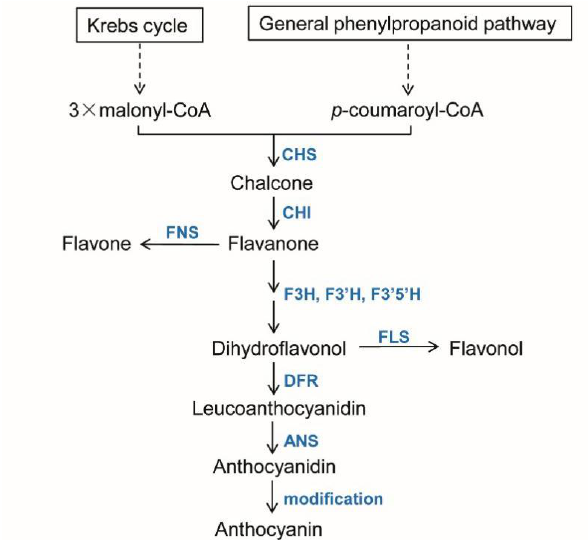
Figure 1. A schematic view of the biosynthetic pathways of flavonoids. The biosynthesis of flavonoids begins with the condensation of one molecule of p-coumaroyl-CoA derived from the general phenylpropanoid pathway (GPP) and three molecules of malonyl-CoA from the krebs cycle. Key enzymes are shown in blue letters. The Krebs cycle and the general phenylpropanoid pathway (GPP) are indicated in boxes with solid black lines. Dashed arrows denote multiple steps. Solid arrows represent single biosynthetic steps. CHS, chalcone synthase; CHI, chalcone isomerase; F3H, flavanone 3-hydroxylase; F3′H, flavonoid 3′-hydroxylase; F3′5′H, flavonoid 3′,5′-hydroxylase; DFR, dihydroflavonol reductase; ANS, anthocyanidin synthase; FLS, flavonol synthase; FNS, flavone synthase.